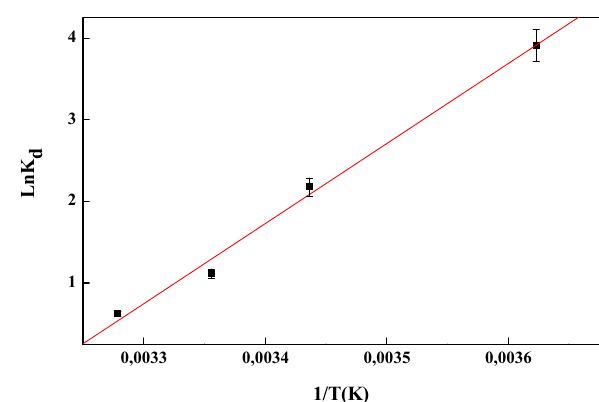
Fig. 13 The thermal variation of K d of diazinon adsorption onto PCW Table 5 Thermodynamic parameters of the diazinon biosorption Temperature ( (cid:3)